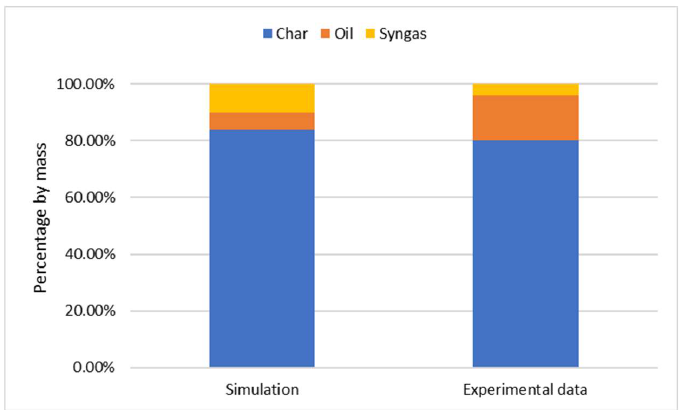
Figure 3. Comparison between experimental results and results predicted by the model in the case of an inert environment with nitrogen.